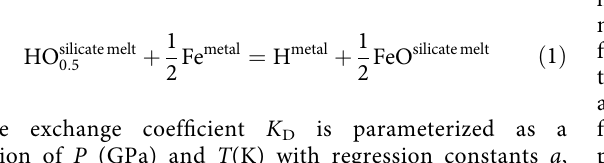
vious studies 2,3 . Least-squares fi tting to our data yields a = 2.42 (18), b = − 2892 (433), and c = − 32.0 (87).